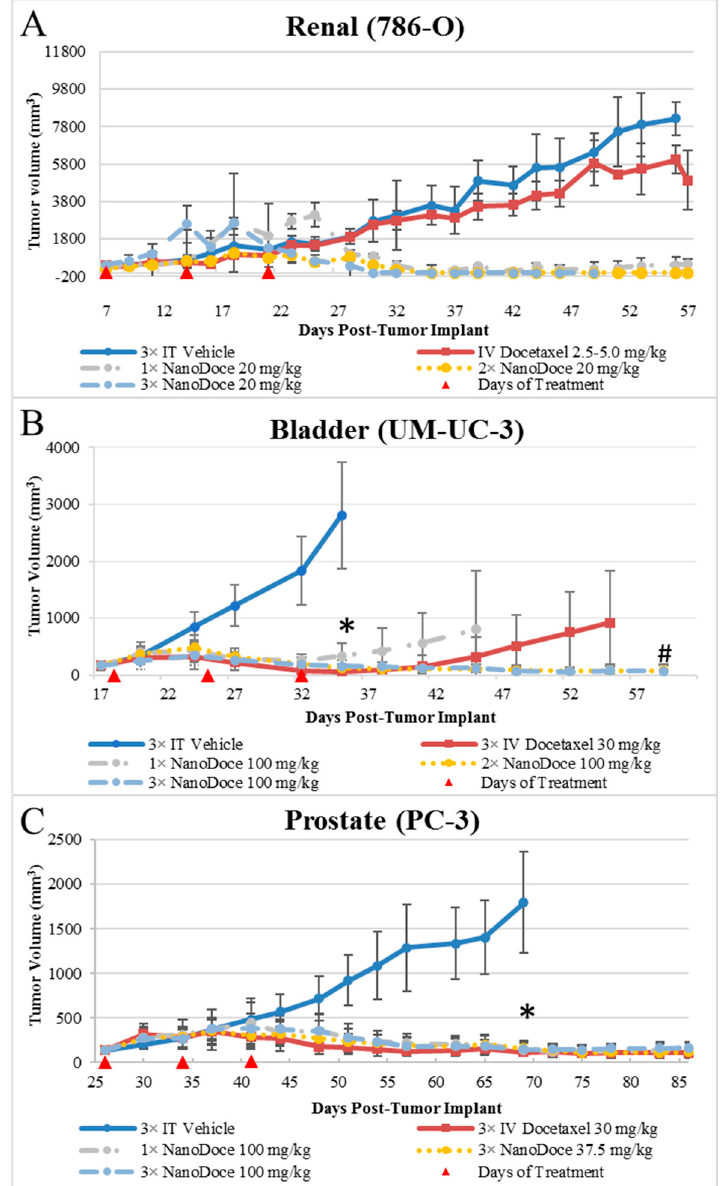
Figure 1. Group mean TVs from treatment initiation to study end. Data plotted through point when ≥ 50% of animals in group survived. Error bars = ±1 Std. dev. ( A ) 786-O xenografts; n = 3/group; treatment was initiated 7 days after tumor implant when group mean TVs ranged from 336–427 mm 3 . ( B ) UM-UC-3 xenografts; n = 9 or 10/group; treatment was initiated 18 days after tumor implant when group mean TVs ranged from 161–164 mm 3 . * p < 0.0001 vs. 3× IT Vehicle; # p < 0.01 for 3× IV Docetaxel